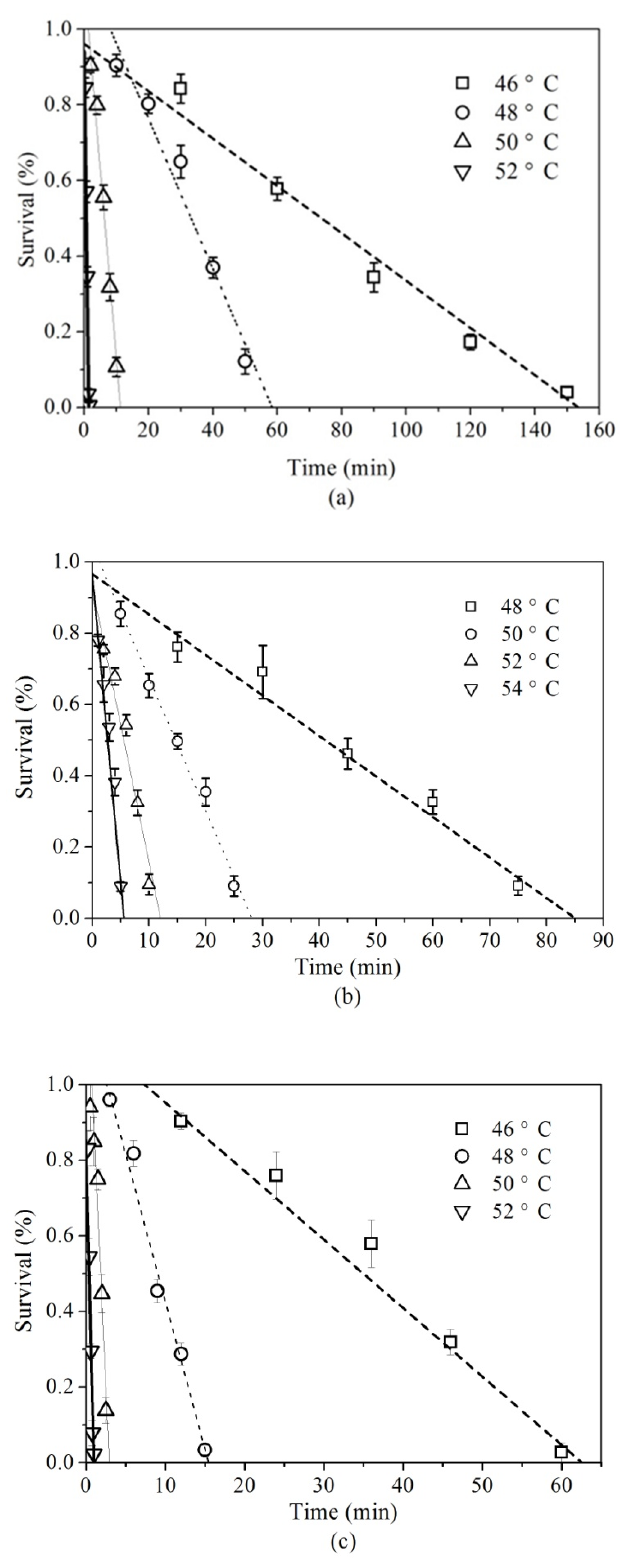
Figure 2. Thermal survival curves at di ff erent temperatures and exposure times of adult: C. pusillus ( a ); R. dominica ( b ); and T. confusum ( c ).